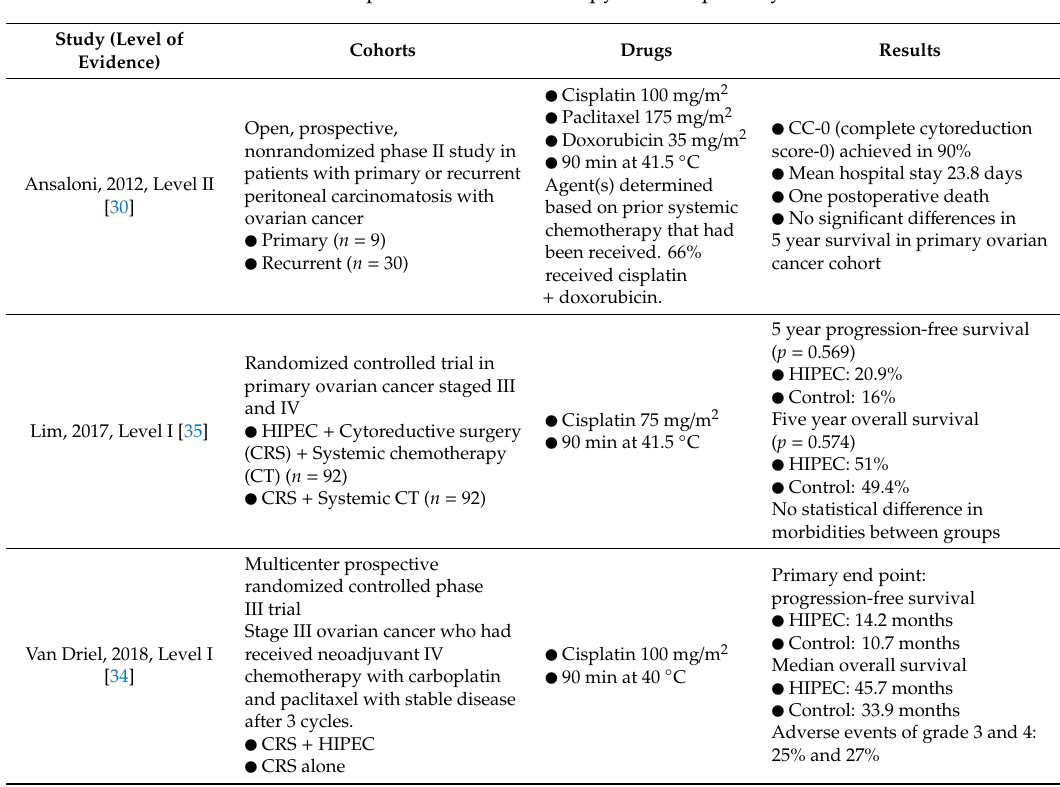
Table 1. Review of intraperitoneal chemotherapy trials in primary ovarian